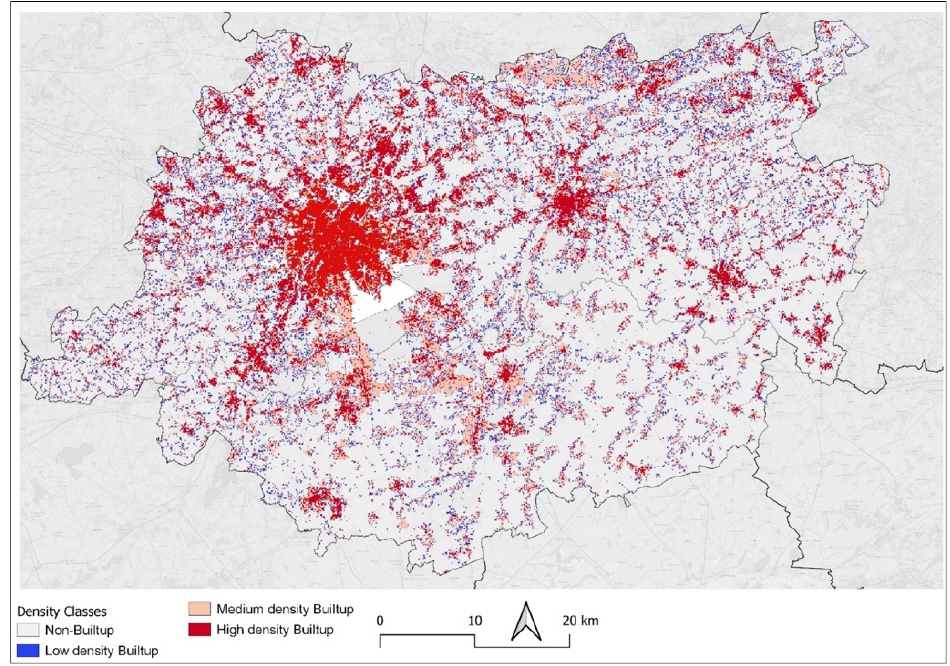
Figure 3. Urban built-up density classes at a square grid of 100 ∗ 100 m .